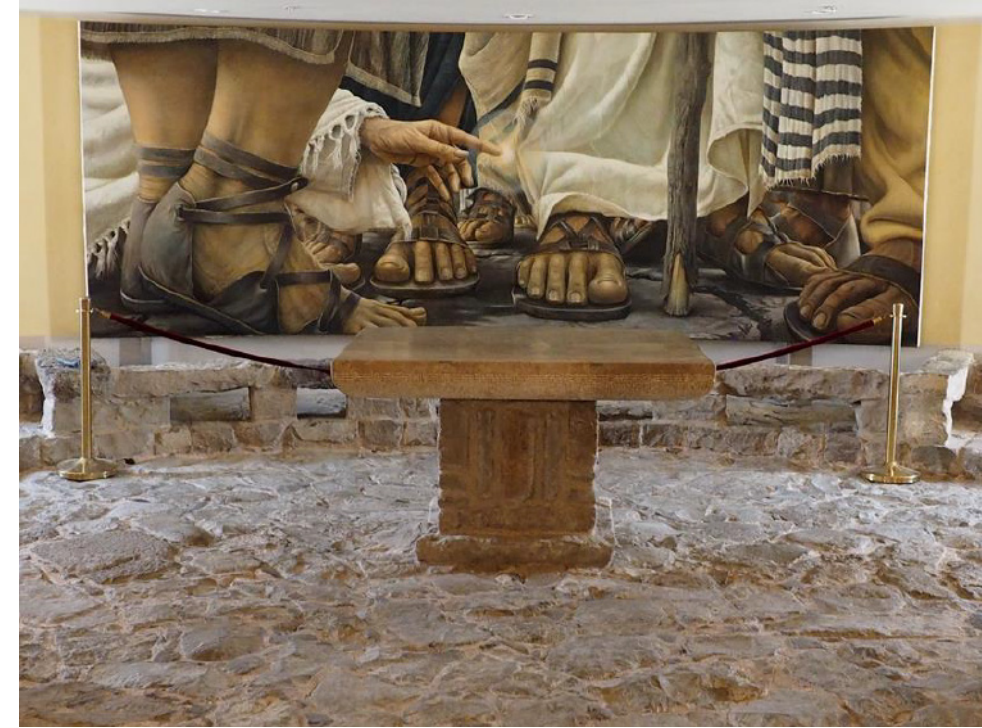
Figure 15. Jesus and the Bleeding Woman, grotto of Duc in Altum (photo: Assaf